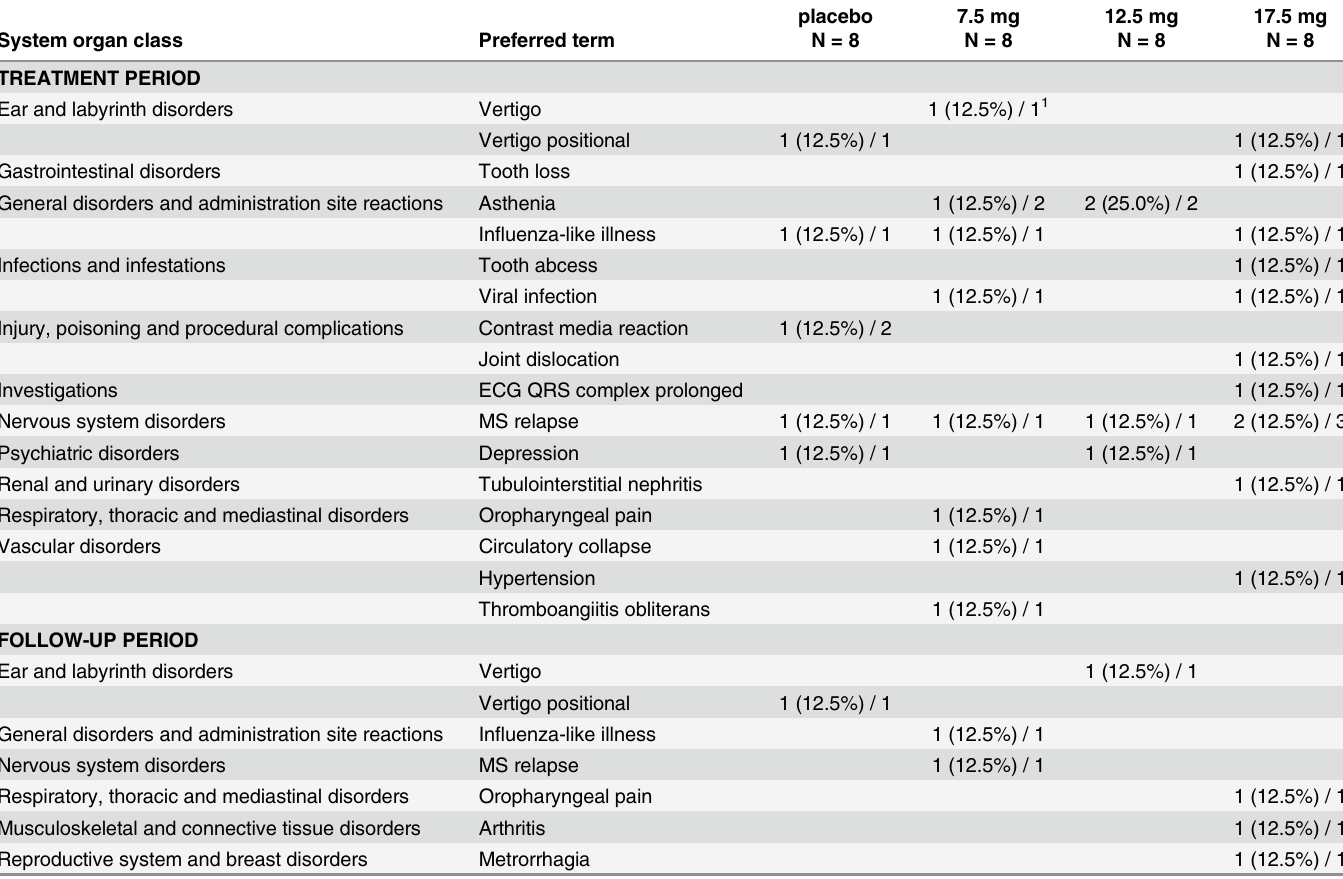
Table 3. Treatment-emergent adverse events occurring during the Phase IIa study in RR-MS